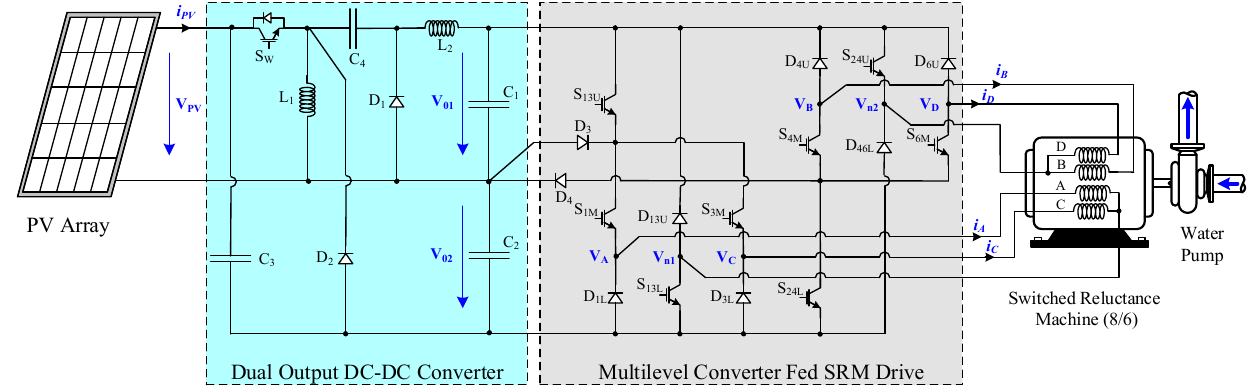
Figure 1. Water pumping system supplied by a PV generator and with an SRM using a drive based on a multilevel converter with reduced switches.